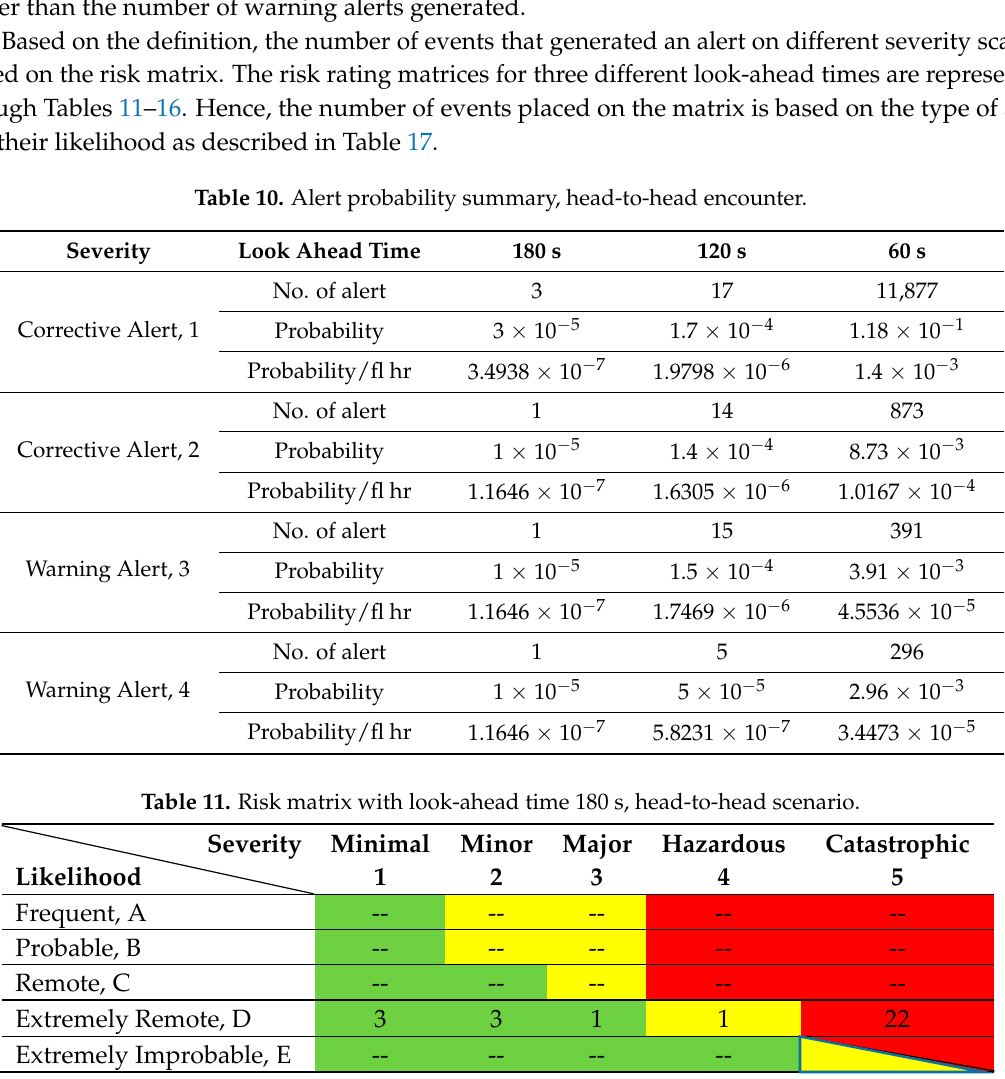
Table 12 . Risk matrix with look-ahead time 120 s, head-to-head scenario.